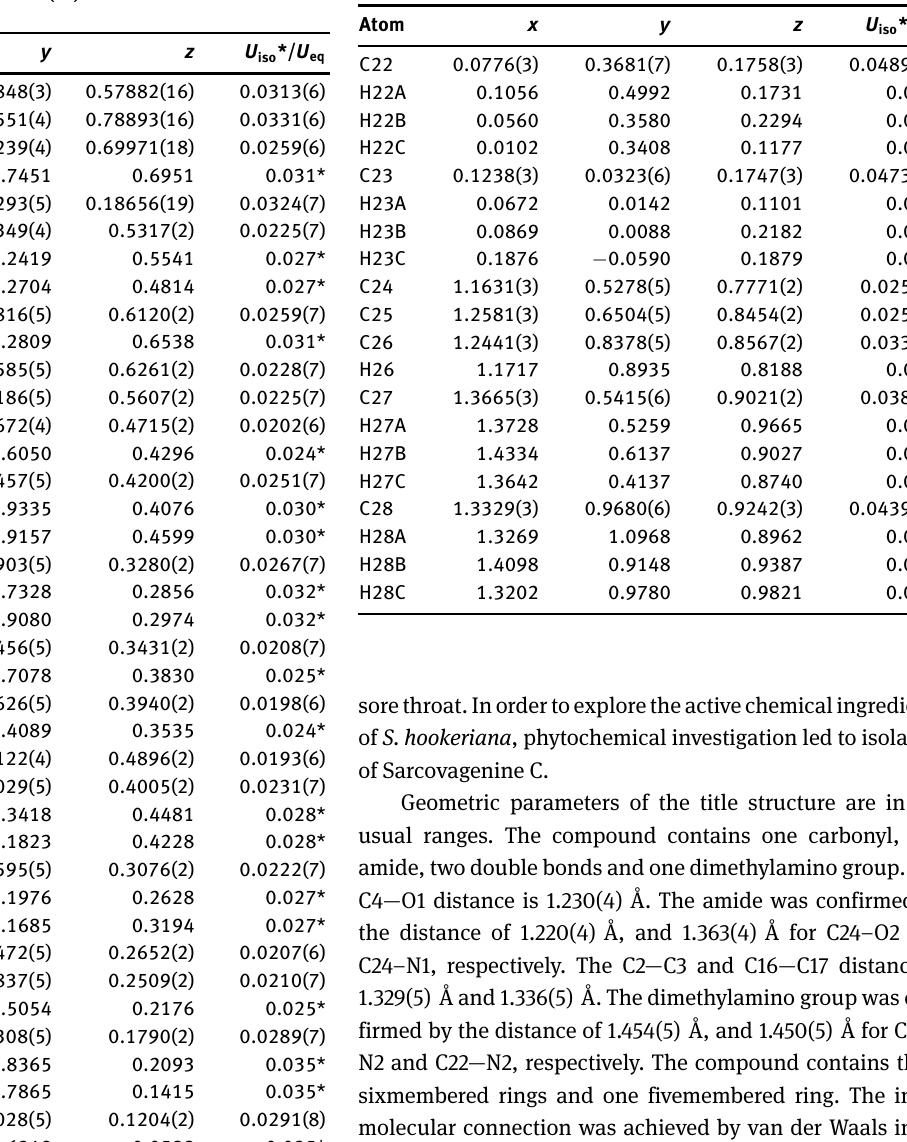
Table 2: Fractional atomic coordinates and isotropic or equivalent isotropic displacement parameters (Å 2